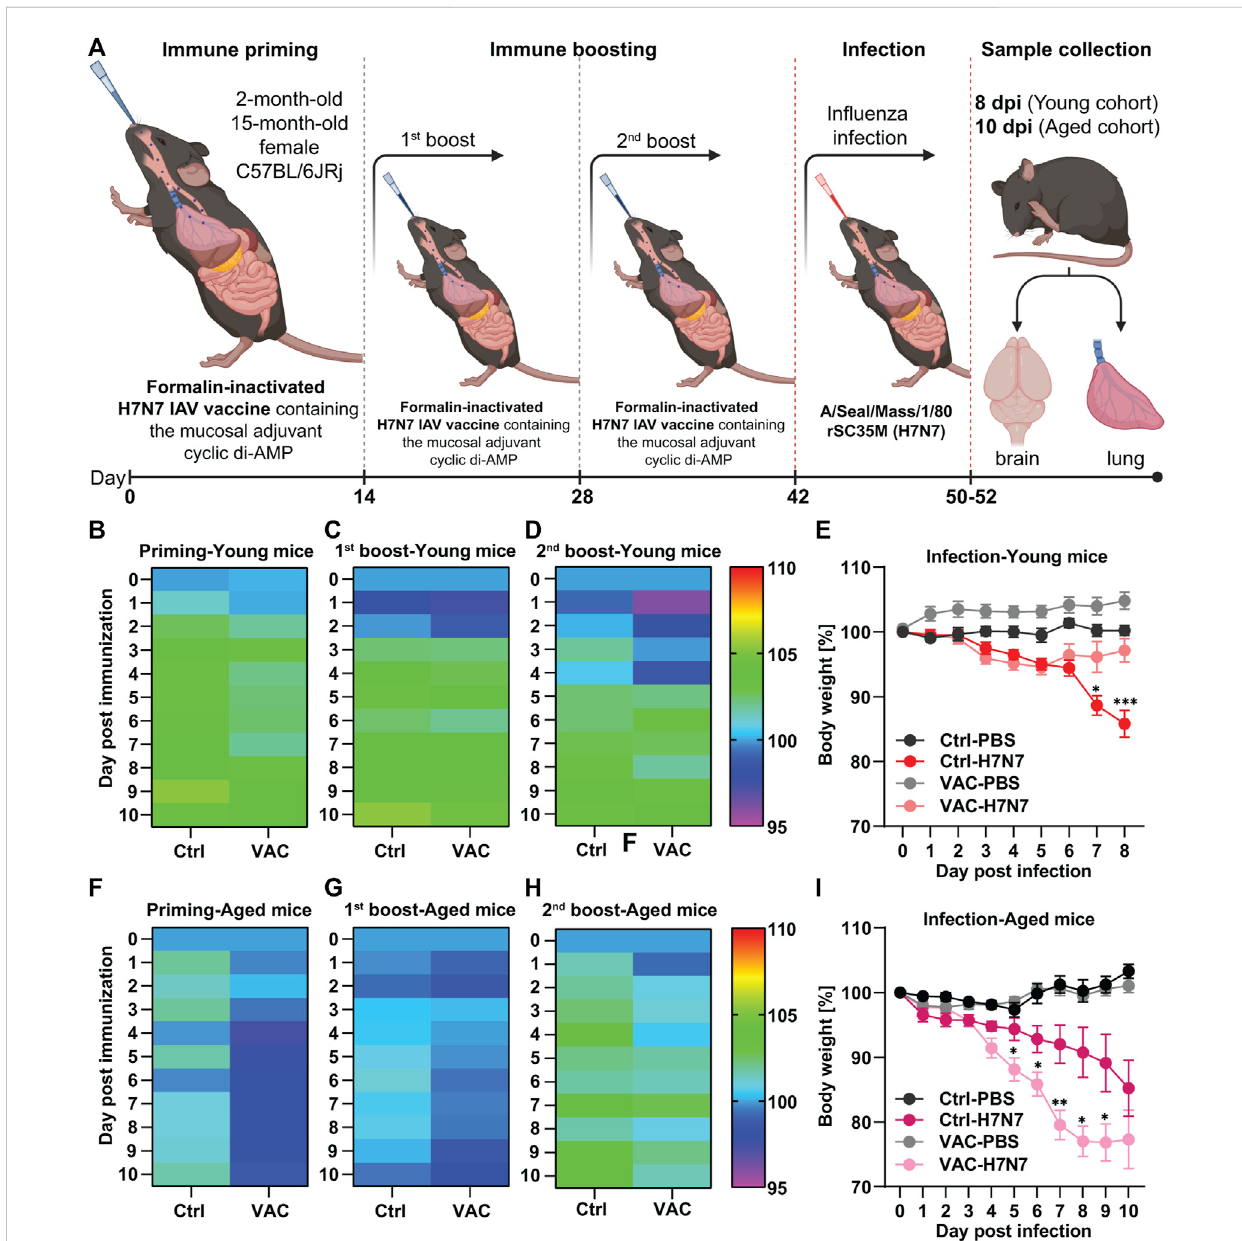
FIGURE 1 ImmunizationofyoungandoldC57BL/6JRjmicewithformalin-inactivatedH7N7IAVvaccineagainstH7N7IAVinfection. (A) Schematicoverviewof theimmunizationscheduleforyoungandoldmicefollowedbyinfectionwith10FFUin fl uenzaA/Seal/Mass/1/80rSC35M(H7N7)virus.Duringthepeakof infection,brainandlungswereharvestedfrombothyoung(8dpi)andold(10dpi)miceforfurtheranalysis(CreatedwithBioRender.com).In2-month-old mice (B) after immune priming, (C) after fi rst immune boost, and (D) after second immune boost, the body weight of the animals was comparable and, after an initial decrease, steadily increased slightly in the following days, although the initial decrease was more pronounced in the vaccinated animals ( n = 28 – 32 animals per group). (E) While the body weight loss was relatively constant after PBS inoculation in both the Ctrl and VAC groups, the bodyweight ofthemiceinfected withtheH7N7IAVbegantodecreaseuniformly byday6post-infection.Betweendays 6and8post-infection,thebody weight of the vaccinated animals returned to the control level, while the Ctrl mice infected with H7N7 IAV lost even more weight ( n = 10 – 14 animals per group).In15-month-oldmice, (F) bodyweight lossafter immune priming wasmore pronounced inthevaccinated group.This wasalsothecase (G) after the fi rst immune boost and (H) after the second immune boost, but not as pronounced as with immune priming ( n = 13 – 15 animals per group). (I) After H7N7 IAV infection, both Ctrl-PBS and VAC-PBS showed similar changes in body weight. However, both control and vaccinated groups infected with H7N7 IAV showed body weight loss from day 4, which was even signi fi cantly greater in the previously vaccinated mice ( n = 6 – 8 animals per group). Data are presented as mean ± SEM and were analyzed with the repeated measures two-way ANOVA followed by Fisher ’ s LSD test; * p < 0.05, ** p < 0.01, and *** p <